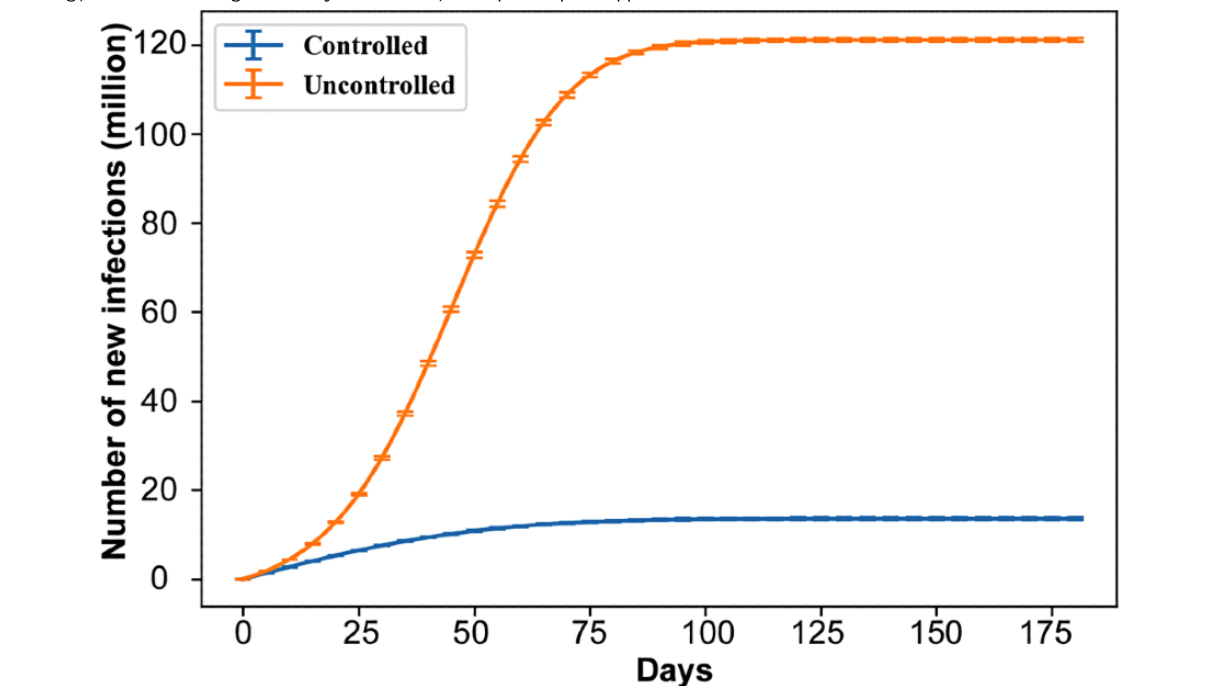
Figure 3. Comparison of changes in cumulative infections between a COVASIM simulation and reality from September 3, 2020, to the end of 2020. The simulation included a reduction on work and school contacts (set to 95% of their capacity), 600,000 daily and highly sensitive tests, quarantining upon testing, immediate tracing to identify all contacts, and a presumptive approach.